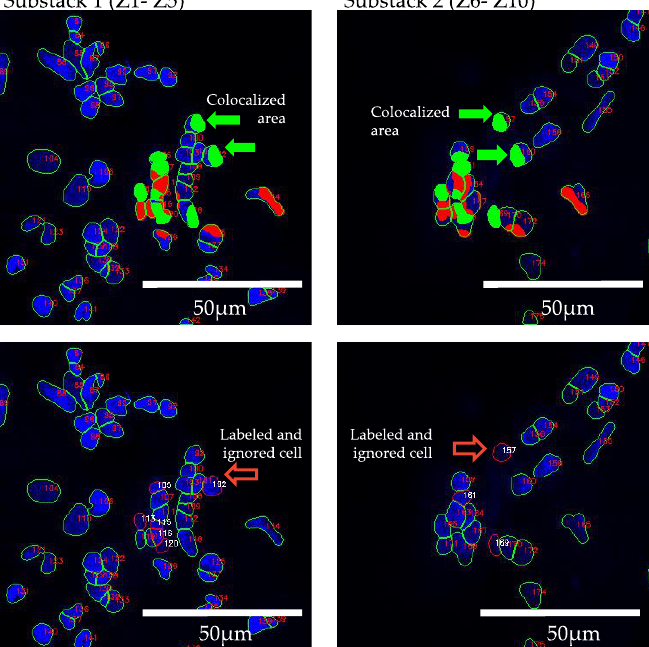
Figure 6. Representation of double-counting analysis. Green and red show shared areas of colocalized nuclei in two sequential projections (substack 1 contains planes 1–5, substack 2 contains planes 6–10). Red indicates that the percent of the shared area is smaller than the user-defined intersection percent (default value is 60%). Green indicates that the percent of the shared area is larger than the threshold. The nuclei outlined with red are labeled as double-counted cells and ignored in the next analysis.